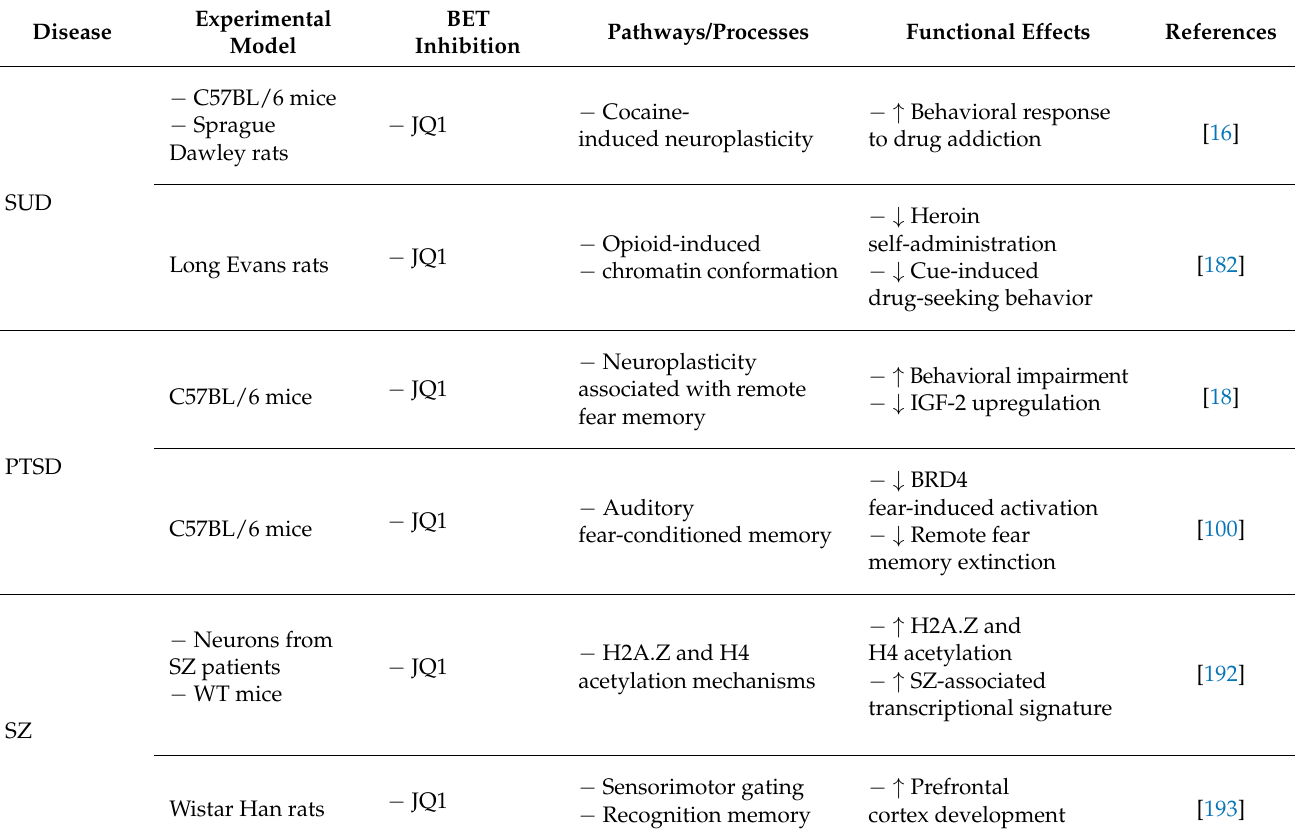
Table 2. Effects of BET inhibition in neuropsychiatric disorders. ↑ indicates an increase; ↓ indicates a decrease. SUD (Substance Use Disorder); PTSD (Post-Traumatic Stress Disorder); SZ (Schizophrenia).